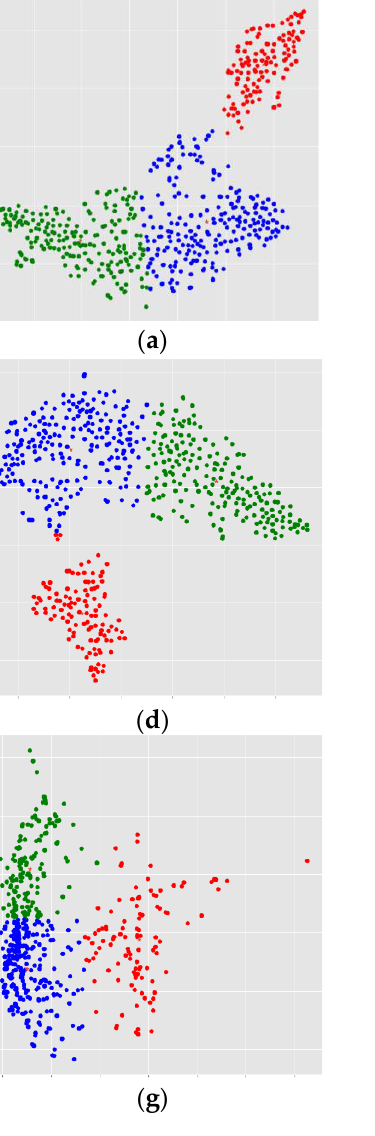
Figure 9. Graphical display of the 27 possible phenotypes that have emerged from the methodology proposed in this work, applied to the OASIS-3 dataset using 9 PPis and cross-correlated hyperpa- rameters. The upper 3 graphs in a horizontal line ( a – c ) were obtained using UMAP; the three in the middle ( d – f ) were produced using t-SNE; and the three at the bottom ( g – i ) were produced using ISOMAP. The column on the left is for RSF, the column in the middle is for PVC2C, and the column on the right is for the noPVC correction. Cluster 1 is in red, cluster 2 is in green, and cluster 3 is in blue in all plots.